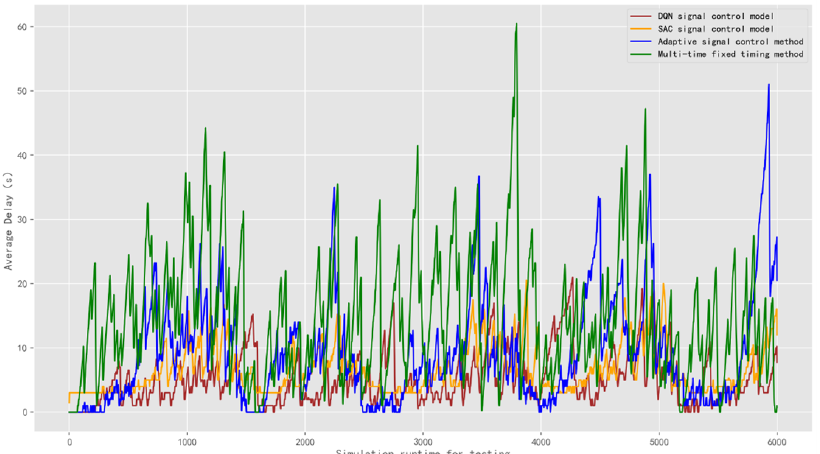
Figure 16. Comparison of the average delay of signal control methods under test traffic scenario